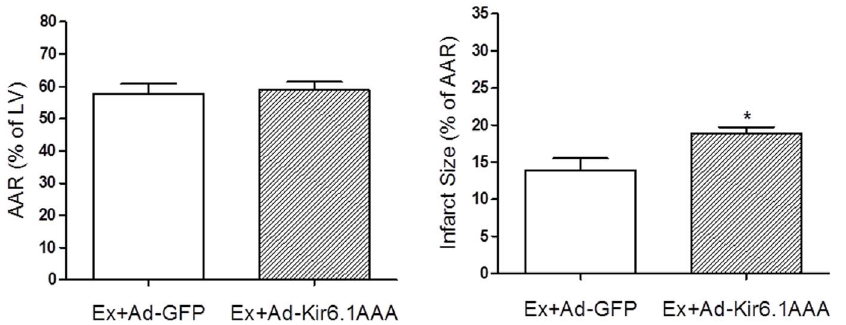
Figure 9. The effect of Kir6.1AAA transfection on myocardial I/R injury in the exercised mice. After 1 week of Ad-Kir6.1AAA-GFP transfection, the exercised mice were subjected to LAD occlusion followed by 24 h reperfusion. AAR (A) and infarct size (B) were measured with Evans blue and TTC staining. As shown, there was no significant difference in the AAR, but infarct size was increased significantly ( , 36%) in the Ad- Kir6.1AAA-GFP group compared to that of the Ad-GFP transfected mice. N 5 5/group, *p ,